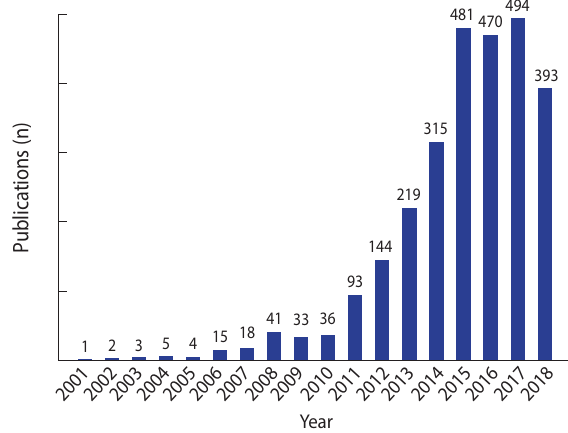
Figure 2. Publications using the National Health Insurance Research Database from 2000 to 2018.